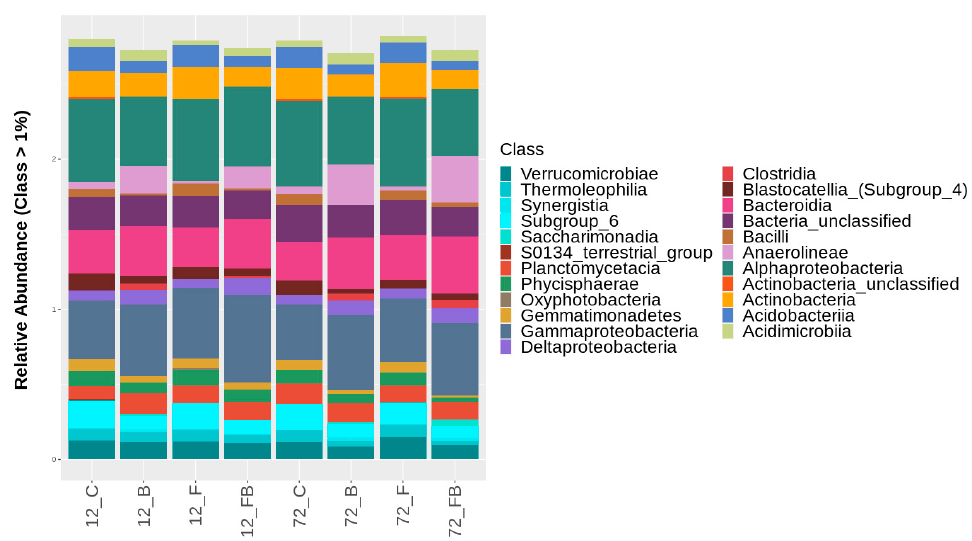
Figure 6. Classification of bacterial classes based on relative abundance at rate greater than 1%, for the treatments control (C), biosolid − enriched treatment (B), Forl inoculation (F), and Forl inoculation with biosolid application (FB) at 12 and 72 h after inoculation with Fusarium oxysporum f. sp. radicis-lycopersici . The different classes are depicted with different colors. Value is the pooled mean of three replicates.